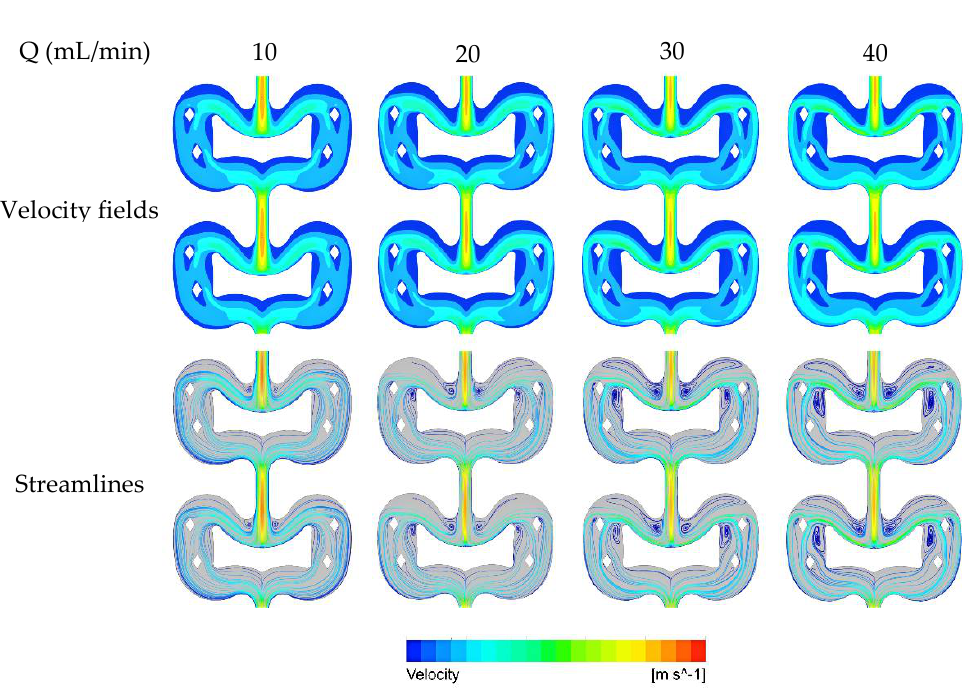
Figure 3. The velocity fields and streamlines of single-phase flow in the butterfly-shaped microreactor under different total flow rates (the closer the color is to blue, the slower the speed, and the closer the color is to red, the faster the speed).